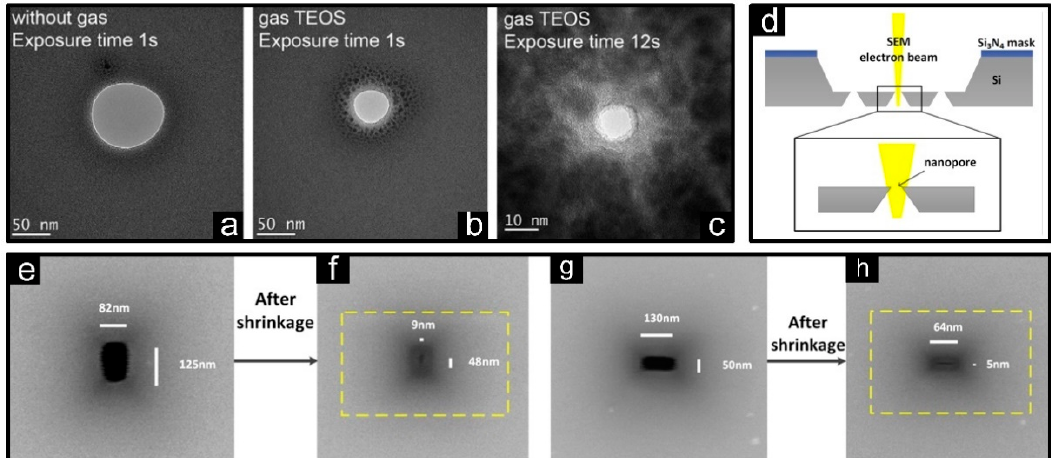
Figure 5. Shrinkage of material deposition or growth. ( a – c ) TEM images of nanopores fabricated by Ion-beam induced deposition with and without Si(OC 2 H 5 ) 4 (TEOS) gas for different exposure times [78] . ( d ) Schematic diagram of election-beam induced deposition. A nanopore before ( e , g ) and after ( f , h ) the EBID process [98] .